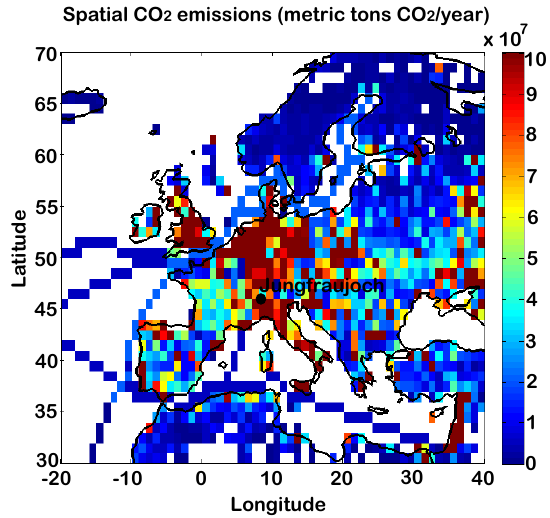
Fig. 1. EDGAR v4.0 comprises anthropogenic CO 2 emissions for the year 2005 (http://www.pbl.nl/en/themasites/edgar/index.html). The colours represent the metric tons of CO 2 emitted by the European countries per grid cell. The strategically good position of Jungfraujoch to observe European CO 2 sources is displayed as a black